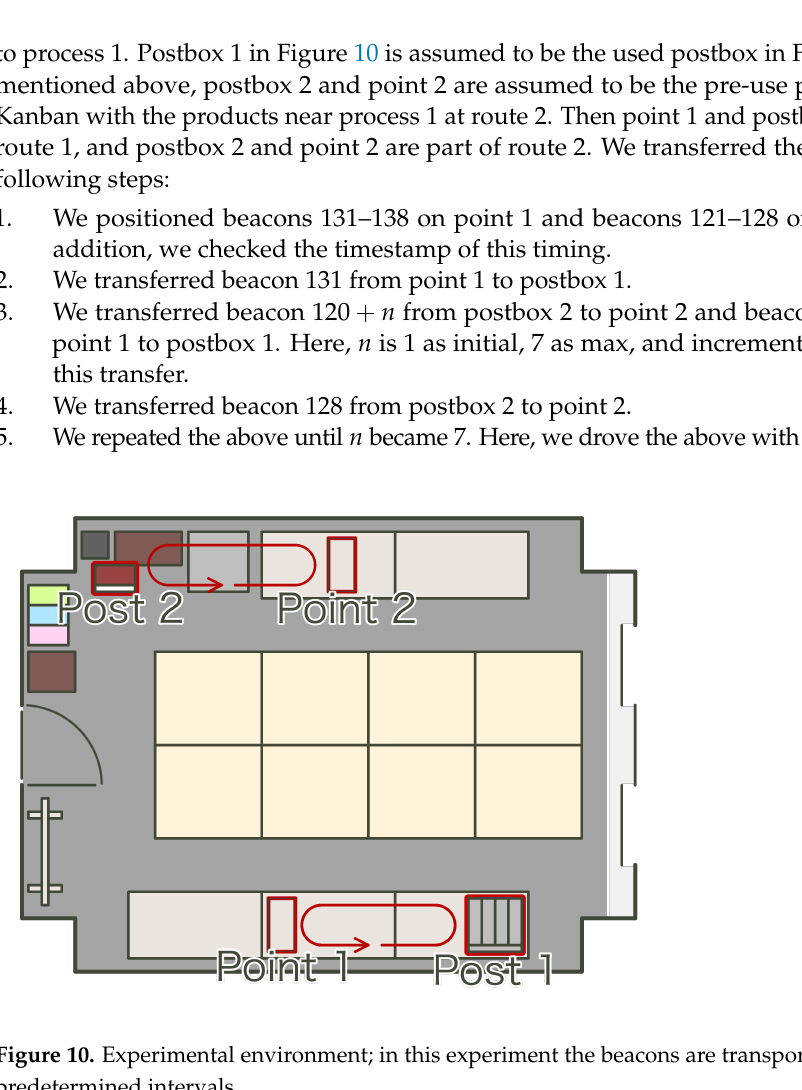
Figure 10. Experimental environment; in this experiment the beacons are transported one by one at predetermined